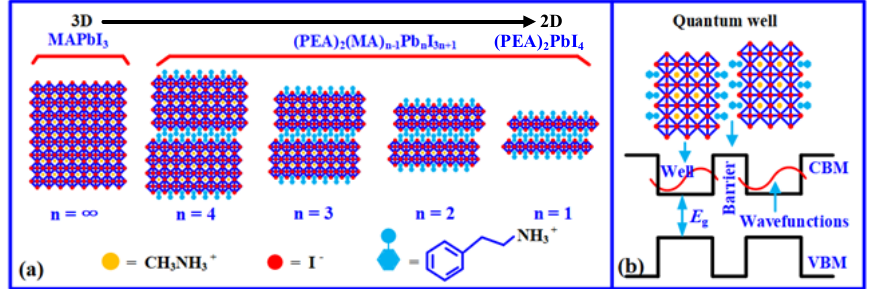
Figure 1. Structural schematic of the perovskites: ( a ) evolution process of perovskites from 3D to 2D and ( b ) multi-quantum well structure.